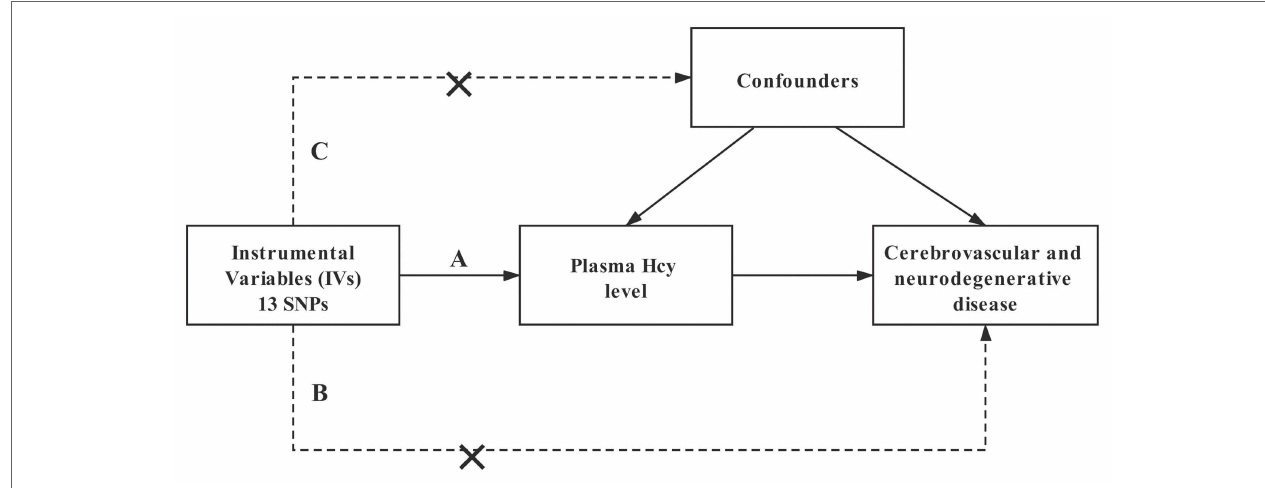
FIGURE 1 | Design and main assumptions of our Mendelian randomization study. SNPs, single nucleotide polymorphisms; Hcy,